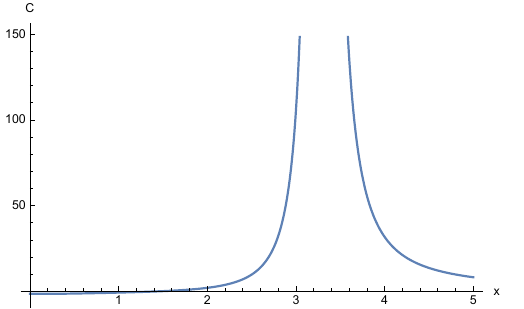
Figure 12. Plot of C ( x ) for x = β G = m = R 1 = M = 1. C > 0 diverges in the unphysical x − region. It is positive in the physical one. The third law is complied